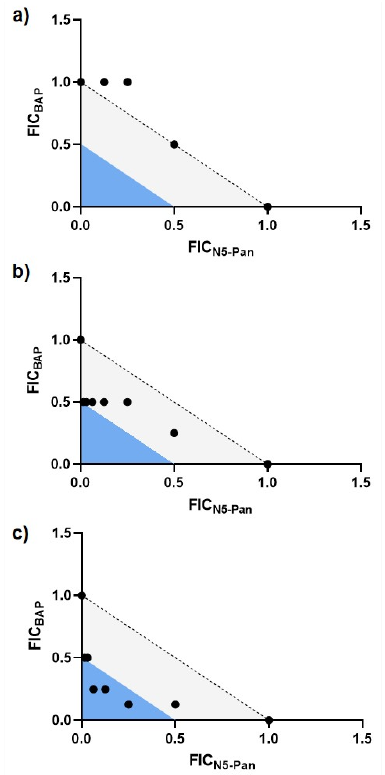
Figure 6. Growth medium effects on the BAP/N5-Pan relationship. Additive or additive-to-synergistic effects are observed in growth conditions where UPEC possess an increased reliance on TCA cycle gluconeogenesis from amino acids. Representative isobologram analyses are shown with points depicting FIC at fractional growth <10% growth; white region indicates indifference (FIC I >1.0), light gray region indicates additivity (FIC I > 0.5 and <1.0), blue region indicates synergy (FIC I ≤ 0.5). ( a ) Isobologram analysis showing additive-to-indifferent relationship in MOPS-glycerol with FIC I observed in the range 0.75–2.00 across experiments for all concentrations; ( b ) Isobologram analysis showing primarily an additive relationship in M9-casamino acids with FIC I observed in the range 0.5–1.03 across experiments for all concentrations; ( c ) Isobologram analysis showing additive-to-synergistic relationship in urine with FIC I observed in the range 0.25–1.01 across experiments for all concentrations.